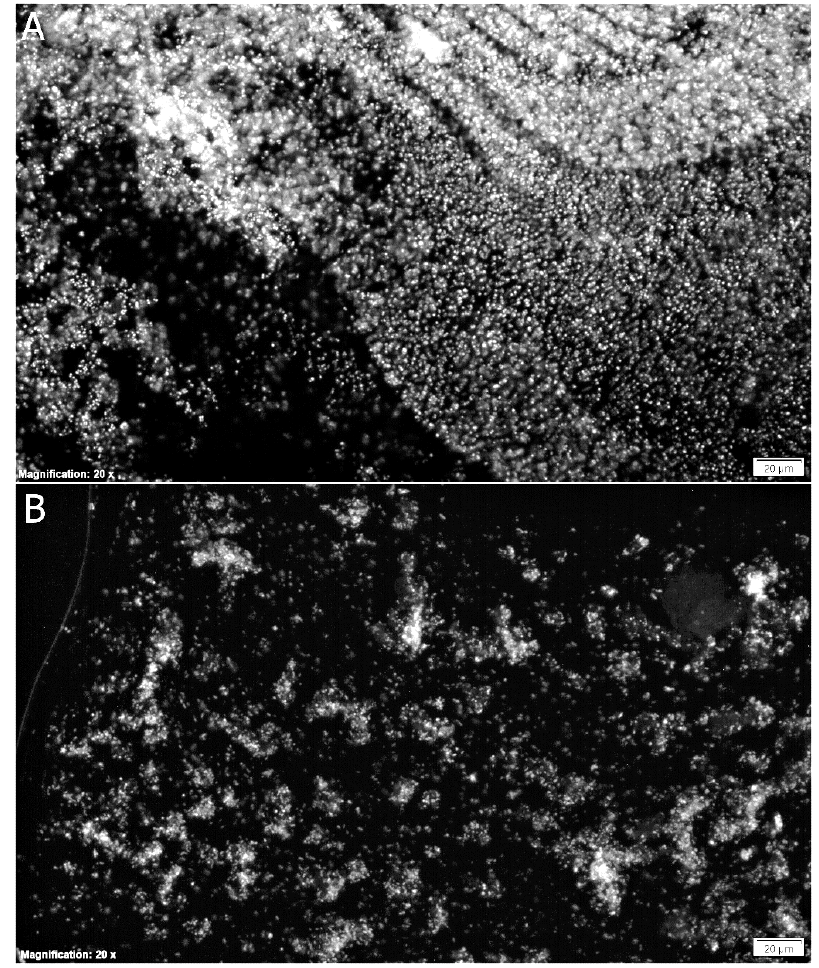
Figure 4. Effect of biofilm eradication by peracetic acid (PAA) (0.250% v/v) in combined action with Q. saponaria extracts (QE) (1% w/v). ( A ) Six ‐ day biofilm of Asaia spp.; ( B ) biofilm eradication by QE and PAA treatment. Bar represents 20 μ m.